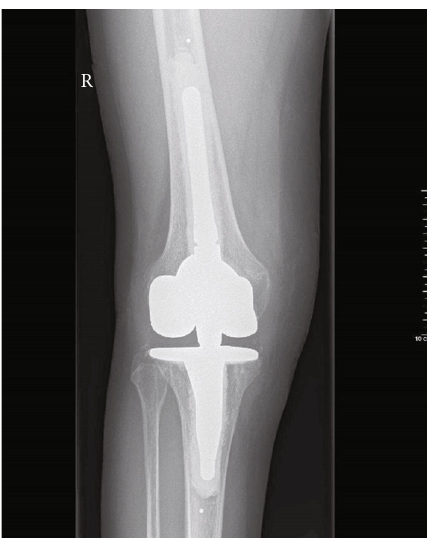
Figure 6: Postoperative radiographs showing the anteroposterior view of the right knee.